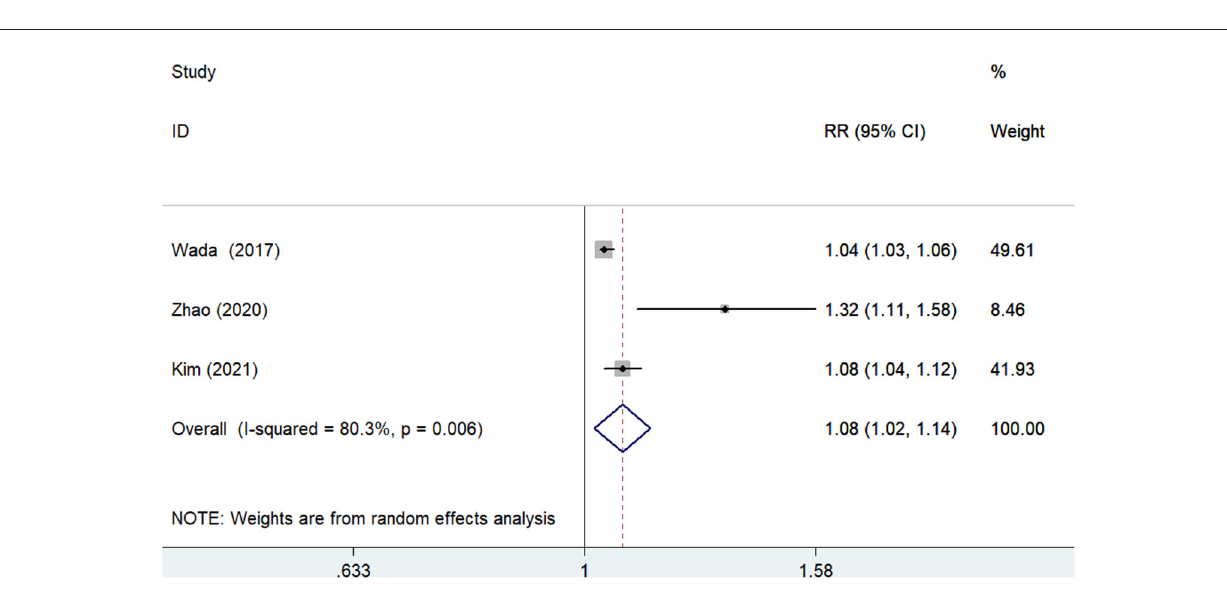
FIGURE 3 | Forest plots showing the pooled RR and 95% CI of all-cause mortality for per point decrease in GNRI. RR, risk ratio; CI, confidence interval; GNRI, Geriatric Nutritional Risk